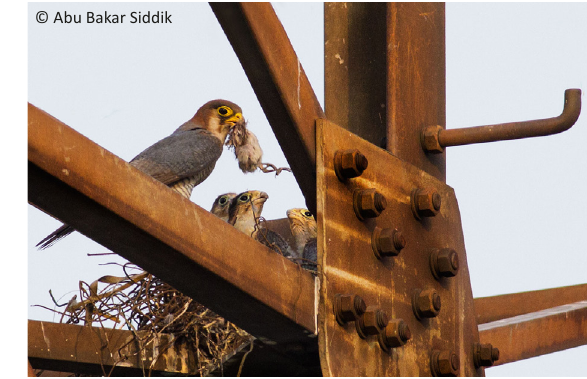
Table 1. Nesting/breeding chronology and duration of nesting/breeding stages. The commencement of each stage was identified by the observation listed. Onset of breeding/ pre-laying